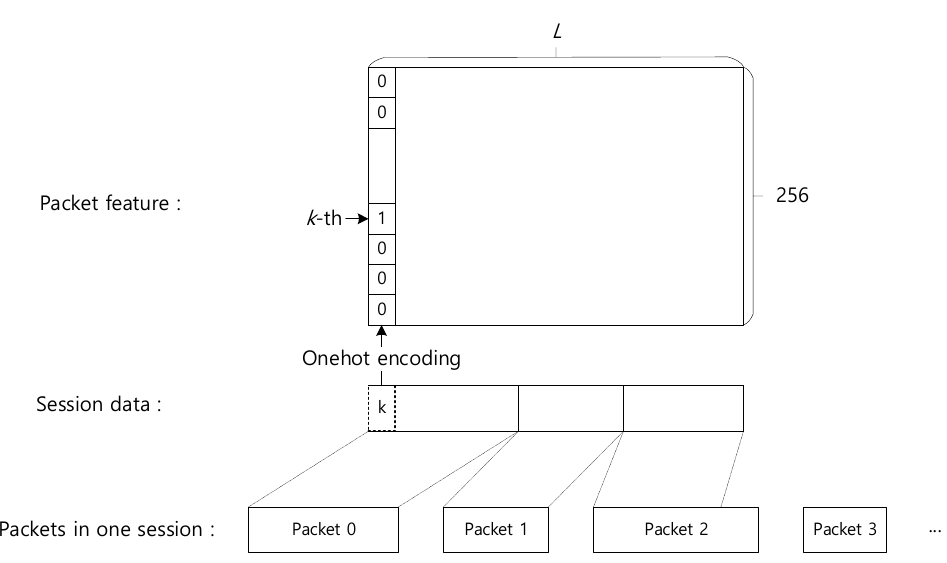
Figure 2. Process of generating packet features used in HAST-IDS.